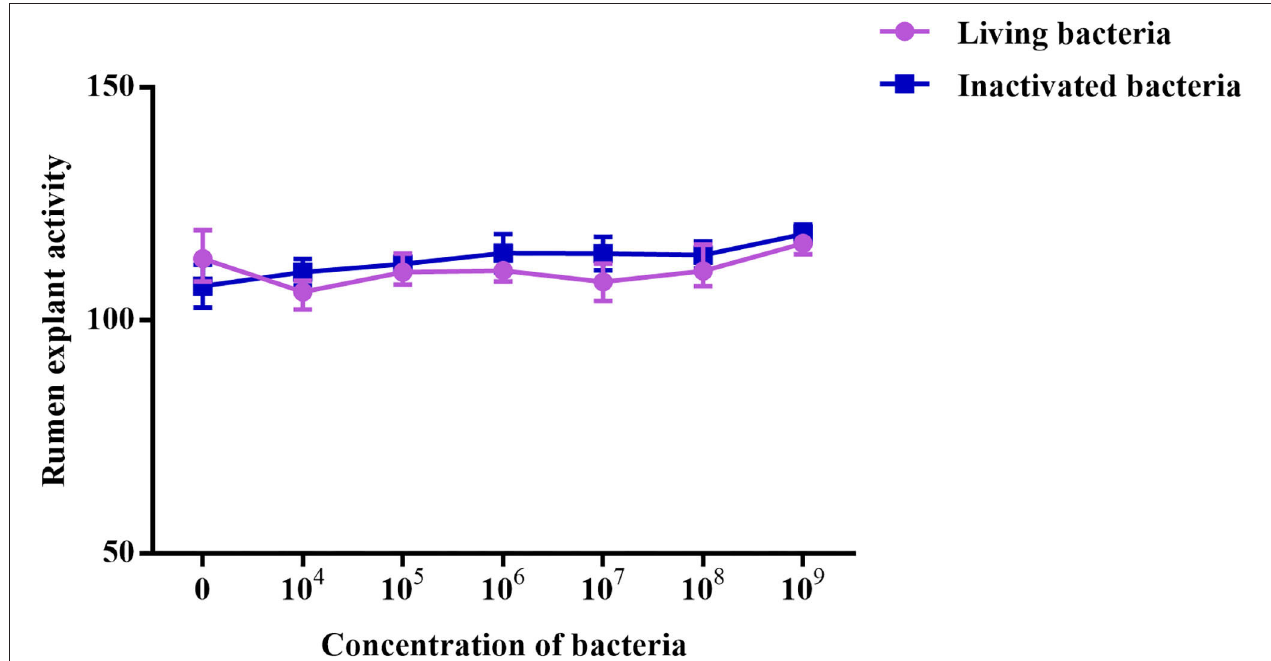
FIGURE 13 | Rumen explants cell activity detected by MTT.MA is rumen explant cultured in medium A containing 10% serum, MB is rumen explant cultured in medium B without serum. The data are presented as mean ± sd. The MTT curve shows that the viability of rumen tissue cells maintained a relatively stable level when the incubation time was between 4 and 12h. By 16h, there was a small decrease in cell viability. At 28h, there was a substantial decrease in cell viability. The cell viability was maintained at a relatively low level as the incubation time continued to